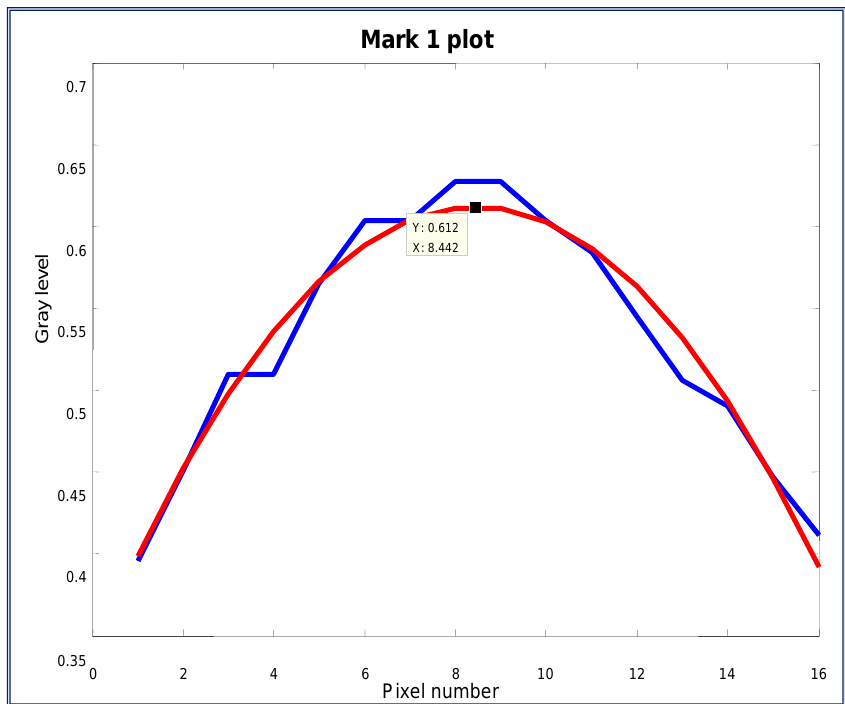
Figure 18. Mark adjustment by using a least square fitting, where y = 0.337528